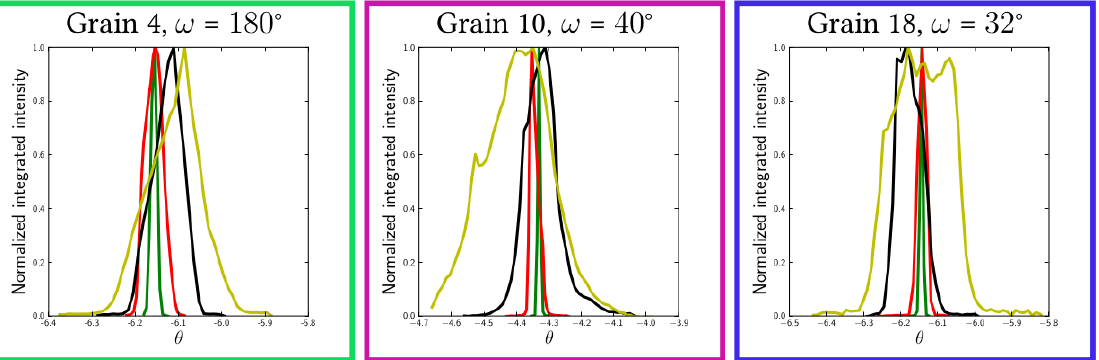
Figure 7. Evolution of the rocking curves for each grain of the cluster during in situ loading; the curve colors (green, red, black, yellow) refer to the load levels in Figure 5, respectively (undeformed, 0.09%, 0.16% and